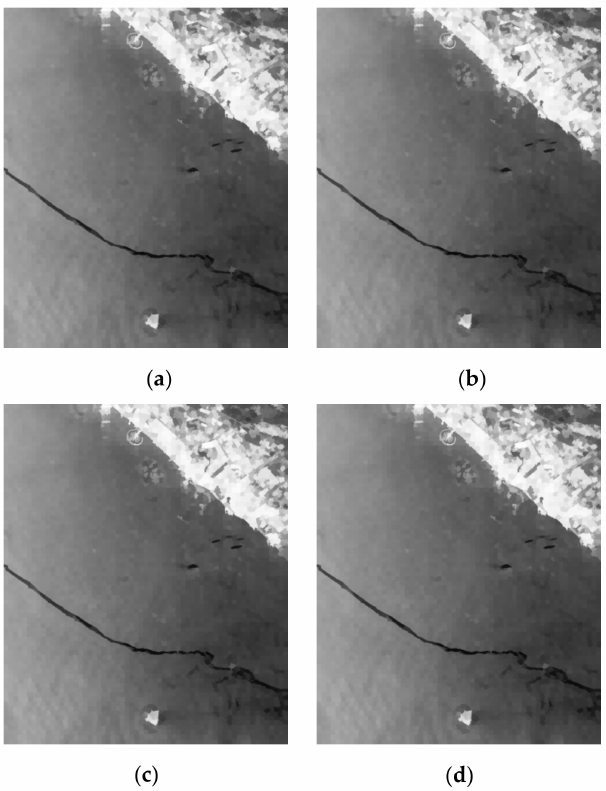
Figure 11. Image stretching results using different inhibition coefficients: ( a ) 1.05, ( b ) 1.1, ( c ) 1.15, and ( d ) 1.2.